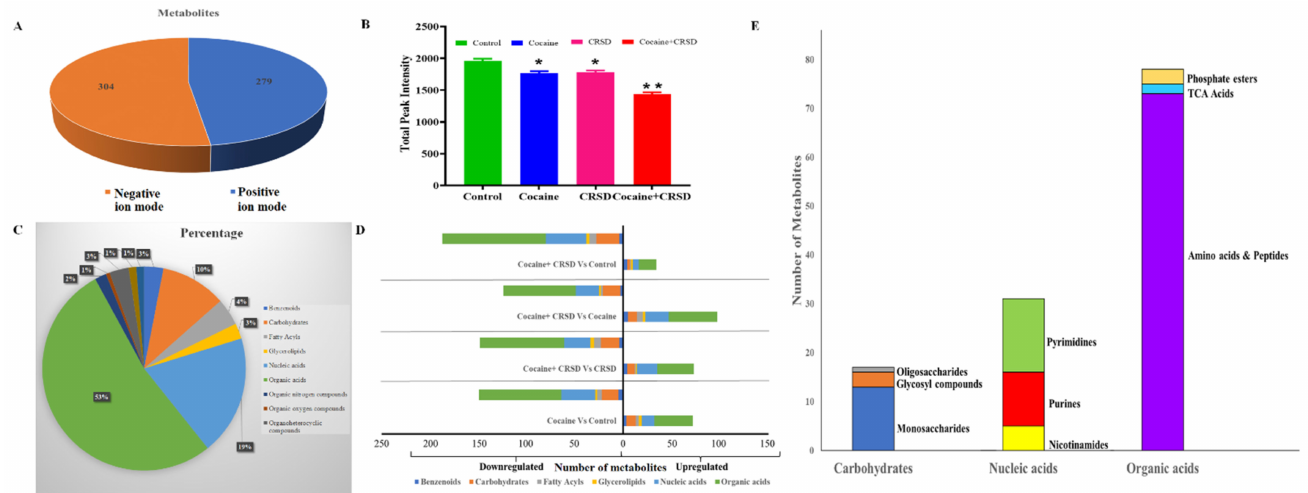
Figure 4. Overview of effect of cocaine and CRSD on metabolomic changes. ( A ) Pie chart showing the total of 304 metabolites and 279 metabolites identified by using positive and negative ion mode of untargeted liquid chromatography-tandem mass spectroscopy, respectively. ( B ) The bar diagram representing the total peak intensities across control, cocaine + CRSD, CRSD, and cocaine groups. ( C ) The pie chart representing the percentage of metabolites belong to superclass of metabolites. ( D ) The stack bar diagram representing the total number of metabolites upregulated and downregu- lated at each comparison groups (Cocaine vs. Control, Cocaine + CRSD vs. Control, Cocaine + CRSD vs. Cocaine, and Cocaine + CRSD vs. CRSD) and distribution of the metabolites per superclass of metabolites. ( E ) The stack bar diagram representing the number of metabolites divided on the basis of subclasses under the superclass. * and ** represent the levels of significance at 10% and 5%,